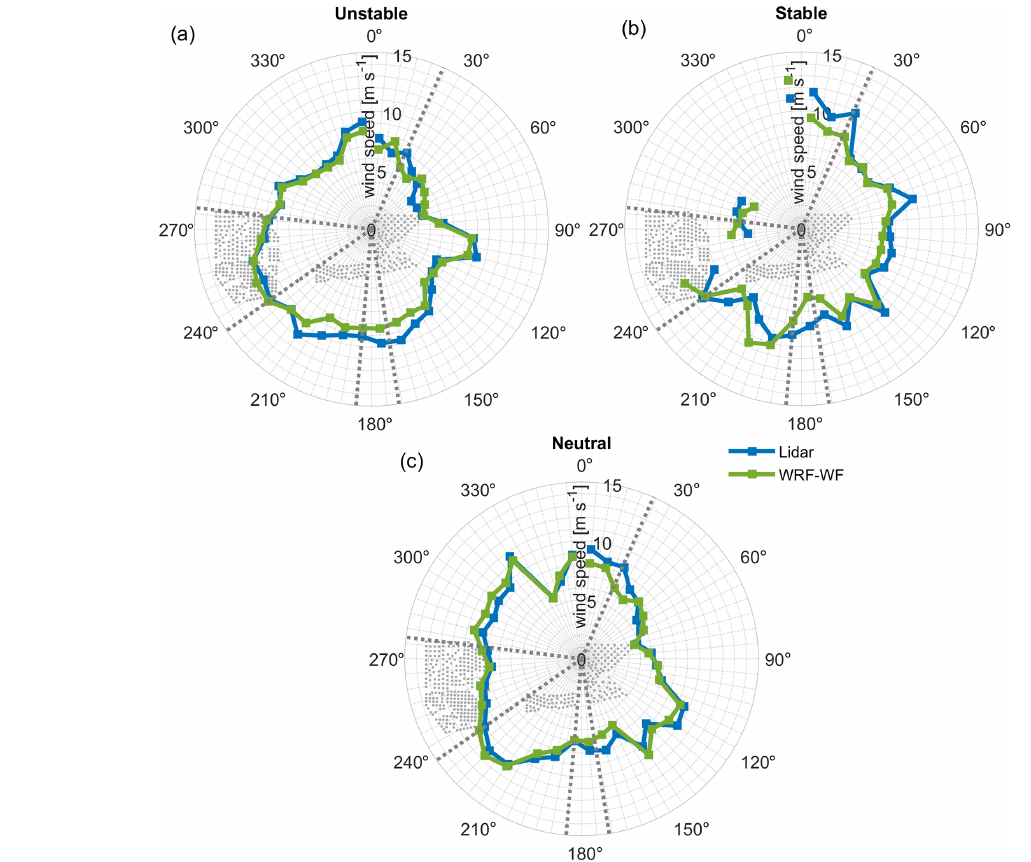
Figure 15. Wind speed polar plots of the lidar measurements and WRF-WF results (with the wind farm parameterization) for (a) unstable, (b) stable and (c) neutral stratification at the height of 120m. Wind turbines are indicated by gray points and the regions R1–5 by dashed gray